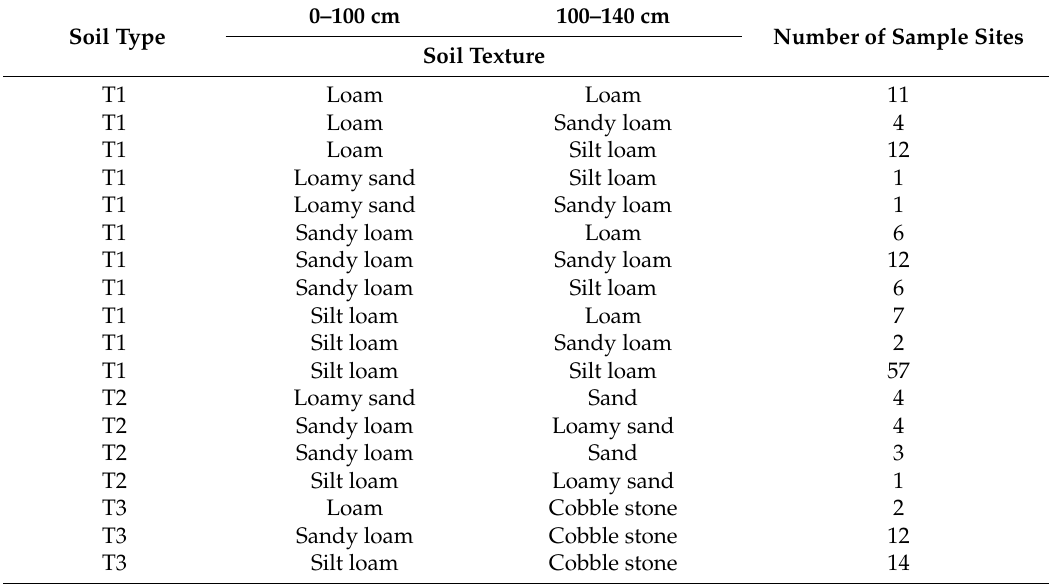
Table 1. Results of soil survey on the layered soil samples.